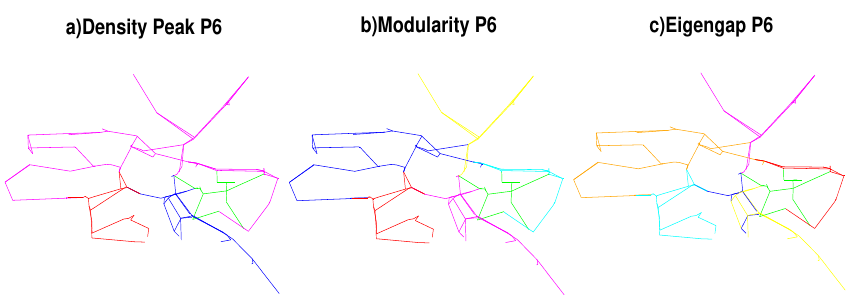
Figure 11. Clustering results for the time period t = 6 in the case of the density peak ( a ), modularity ( b ) and eigengap ( c